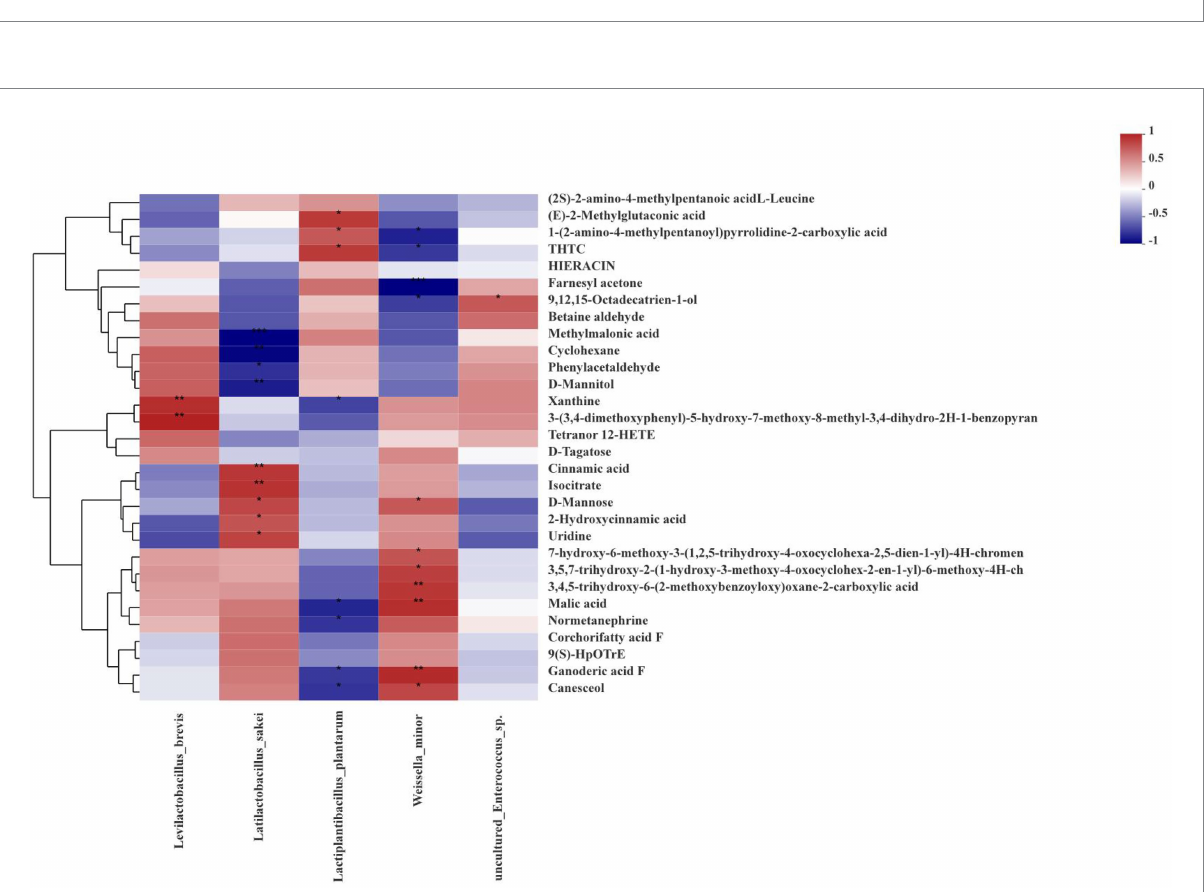
FIGURE 6 KEGG pathway enrichment analysis of the main differential metabolites of ryegrass silage at different growth stages in positive and negative ion modes (SYK, Booting stage; SCK, Initial flowering; SSK, Full flowering). M, and EIP are the class names of metabolic pathways in KEGG annotation. M: Metabolism; EIP: Environmental Information Processing. value of p -uncorrected <0.05 and column chart showing value of p values for the top 20 pathways; * p < 0.05; ** p < 0.01, *** p < 0.001.